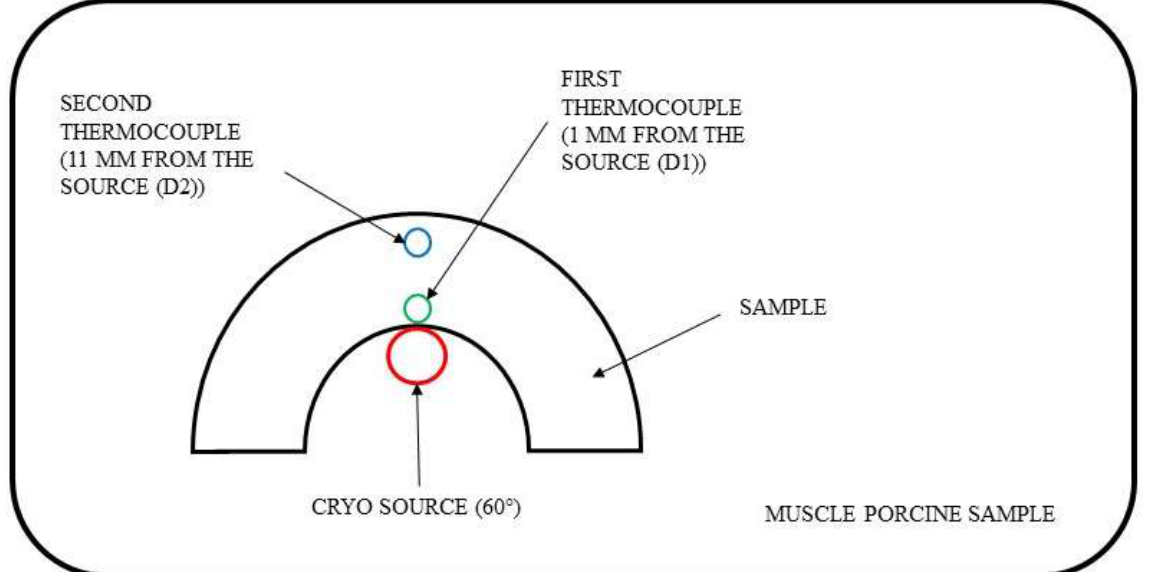
Figure 1. Schematic diagram of experimental tests. The red circle represents the point of cryo- application (with a 60 ◦ cryoprobe–tissue angle); instead, the green circle represents the distance of 1.0 mm from the cryo-application (D 1 ), where the first thermocouple for temperature measurement is located and the blue circle represents a distance of 11.0 mm from cryo-application (D 2 ), where the second thermocouple for temperature measurement is located.